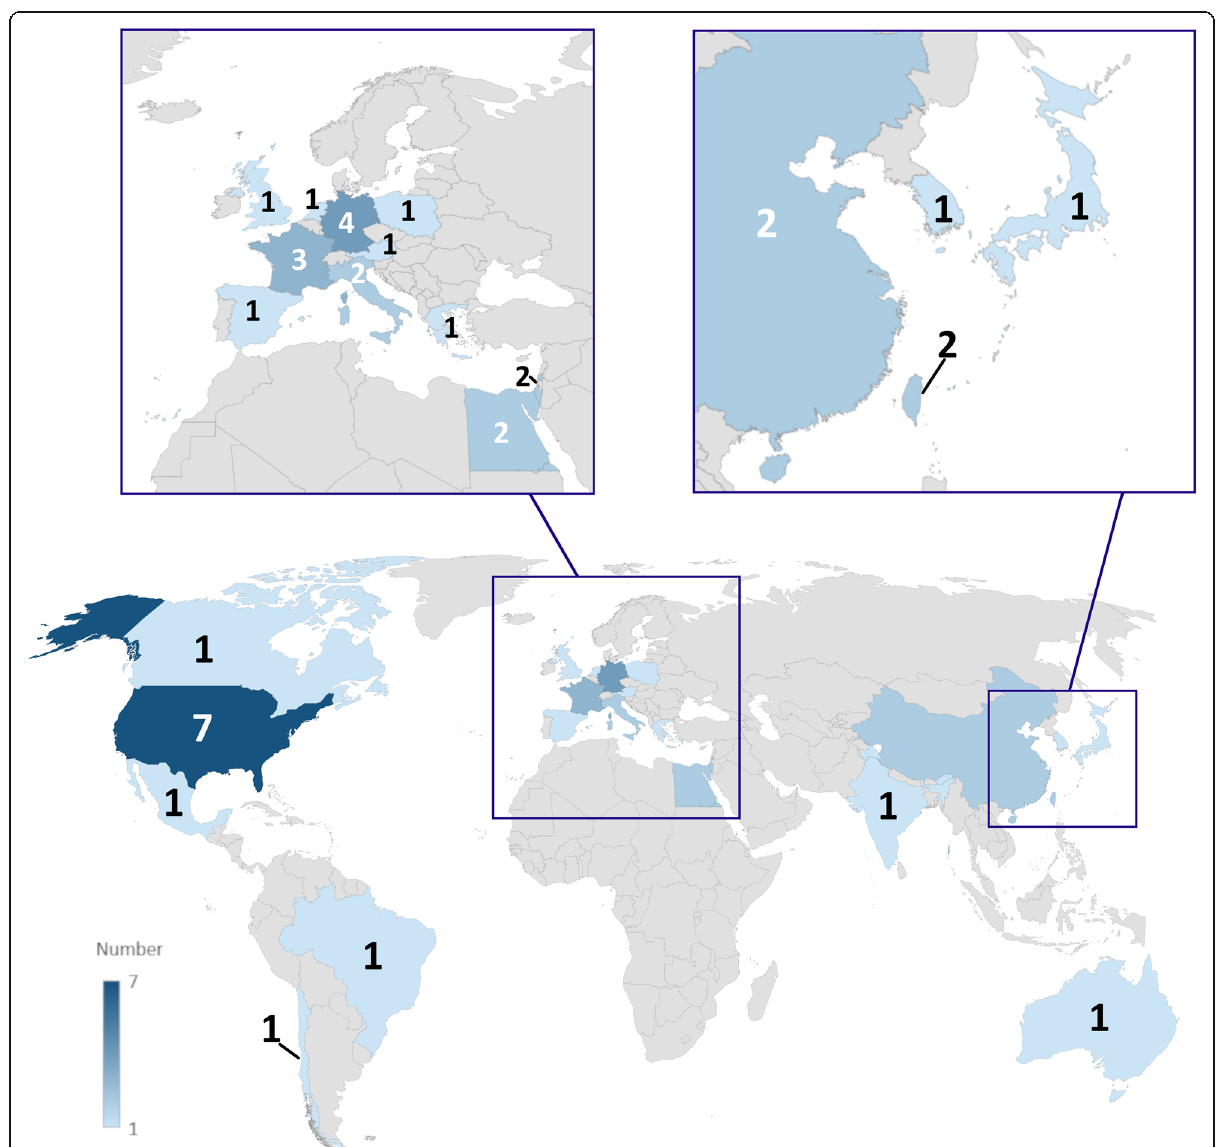
Fig. 2 Geographic distribution of research groups which published results of clinical applications of contrast-enhanced spectral mammography. From very light blue to dark blue, the number of groups progressively increases from 1 to 7; grey colour means no